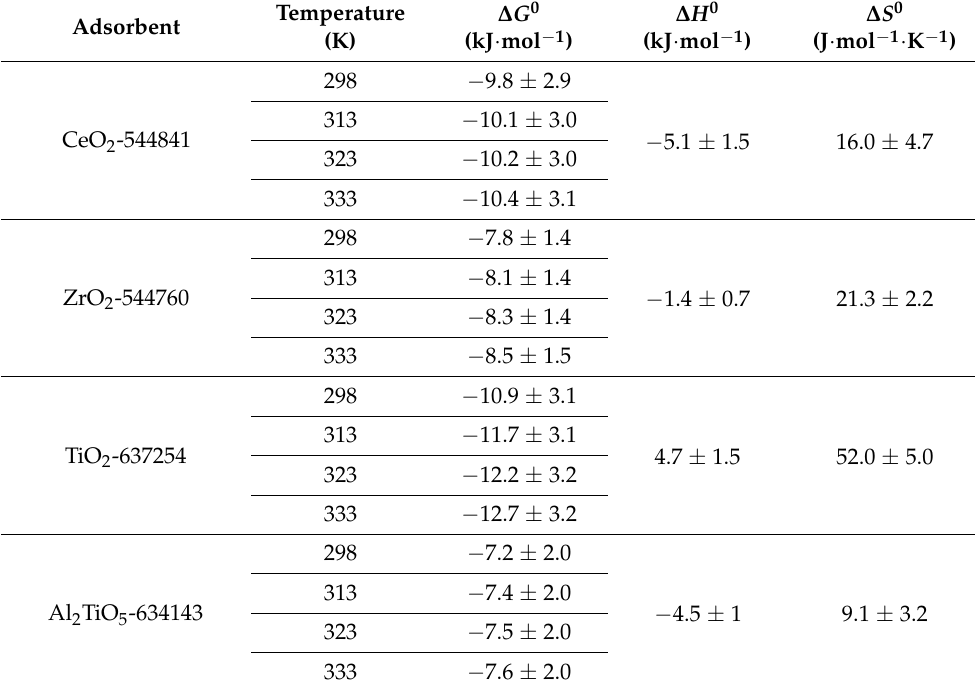
Table 3. Thermodynamic parameters for the sorption of CA- 99 Mo on different metal oxides